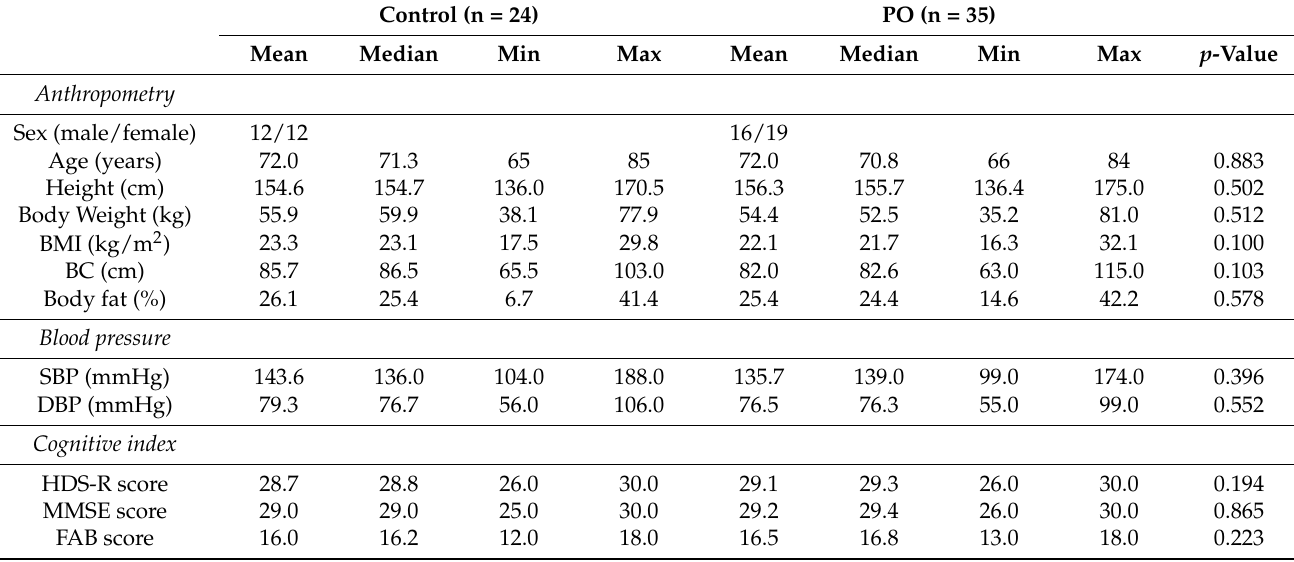
Table 4. Participants’ parameters after 12 months